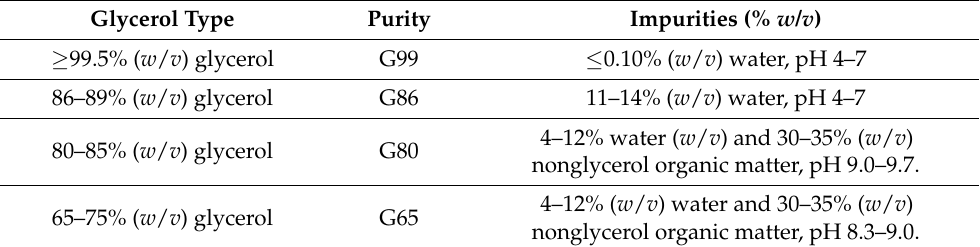
Table 1. Glycerol purity